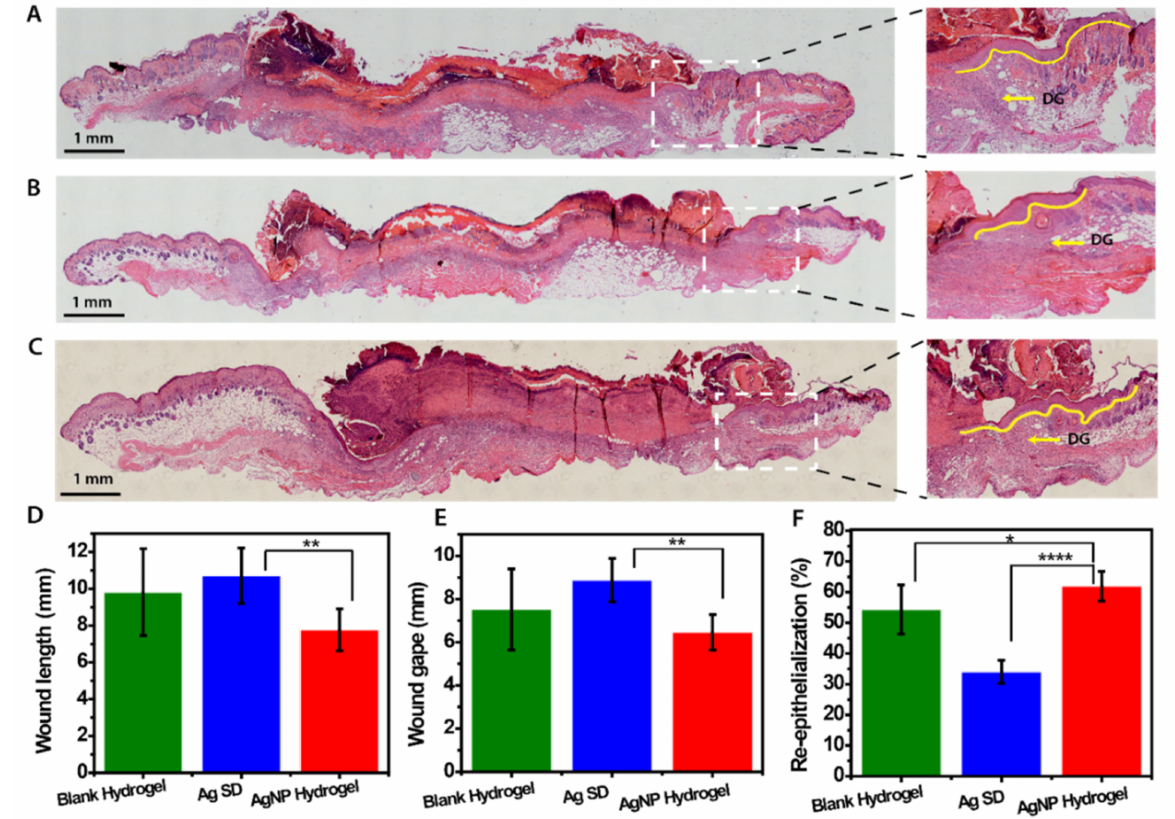
Figure 7. AgNP treatment improves healing and wound reepithelization. H&E-stained blank hydrogel ( A ), Ag SD ( B ), and AgNP hydrogel ( C ) treated wounds with enlarged areas illustrating dermal gape (yellow arrow) and wound re-epithelization (yellow line). Quantitative analysis of wound length ( D ), wound gape ( E ), and percent of wound re-epithelization ( F ) at day 10 post wounding. Data are shown as mean ± SD and the * denotes significant difference using one-way ANOVA followed by Dunnett’s multiple comparison test. * p < 0.05, ** p < 0.01, and **** p < 0.0001, n =